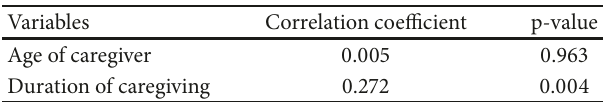
Table 5: Correlation coefficients (r) between caregivers’ depression scores with their age and duration of